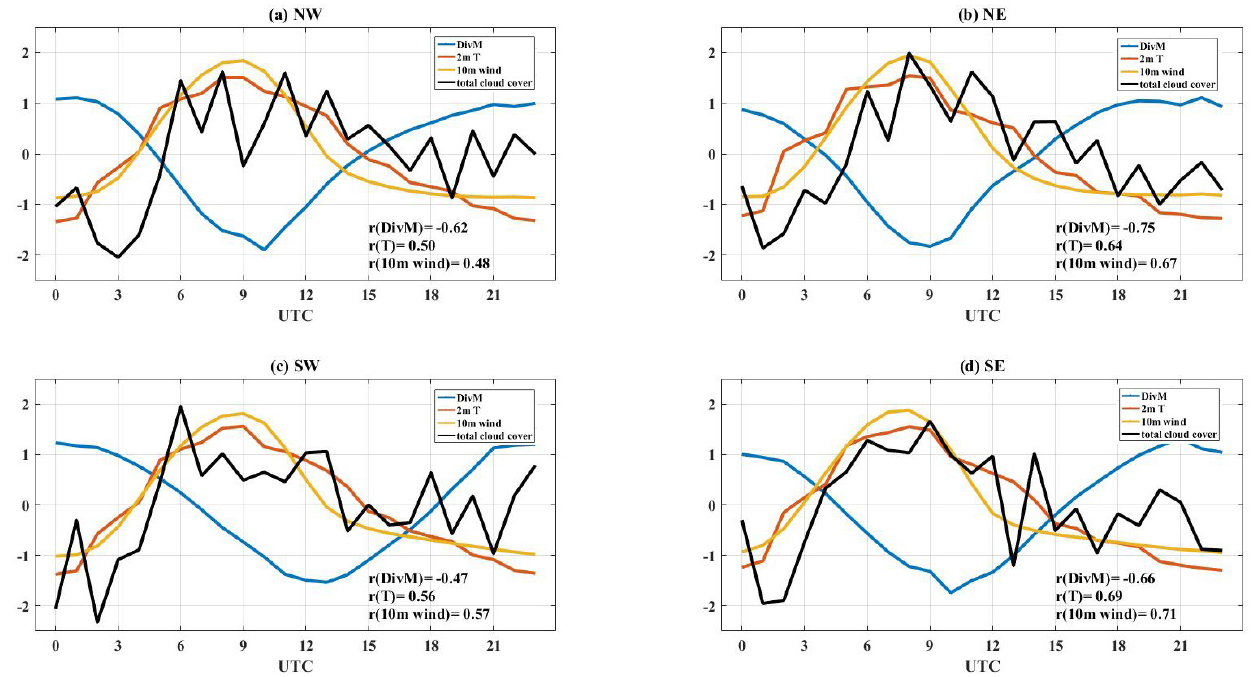
Figure 8. The standardized total cloud cover (black lines) and vertically integrated divergence of moisture flux (kgm − 2 s − 1 ) (blue lines), 2m temperature (K) (red lines), and 10m wind speed (ms − 1 ) (yellow lines) of the different regions of the TP: (a) the northwestern TP, (b) the northeastern TP, (c) the southwestern TP, and (d) the southeastern TP. The correlation coefficients are indicated in the bottom-right corner. The correlation coefficient in bold indicates that it can pass the 90% significance